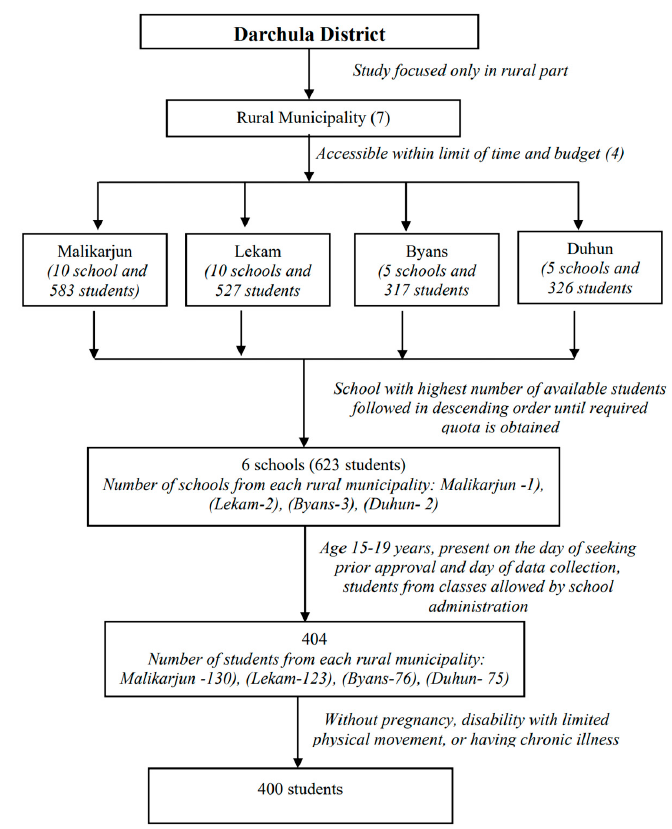
Figure 1. Selection of students for data collection.